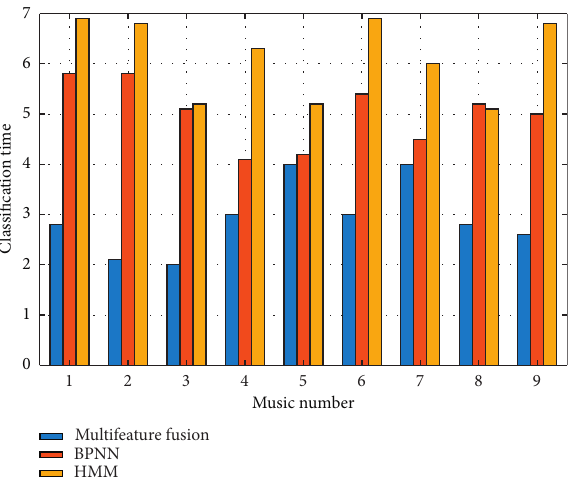
Figure 7: Comparison of three music classification models by time